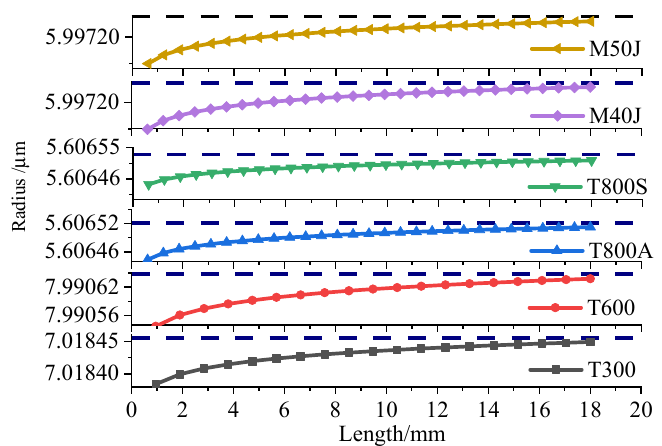
Figure 6. Relationship between the length and width of the carbon fibre under external force.